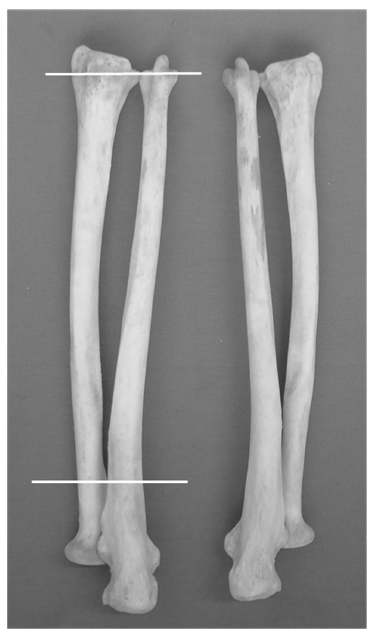
Figure 2 - Well-preserved dry forearm bones from a cadaver. The lines mark the proximal and distal levels corresponding to the sections evaluated by computed tomography.